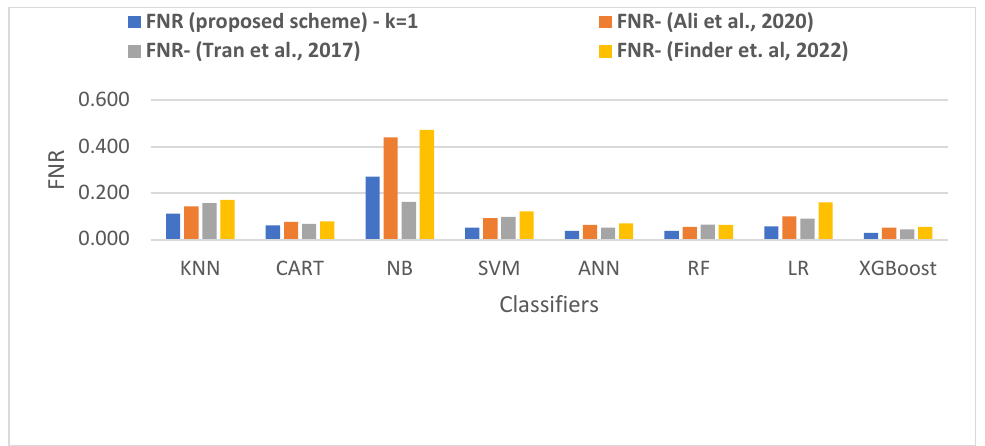
Figure 10. The comparison of the FNRs between the proposed DIEBD-based scheme and the related work-based schemes.